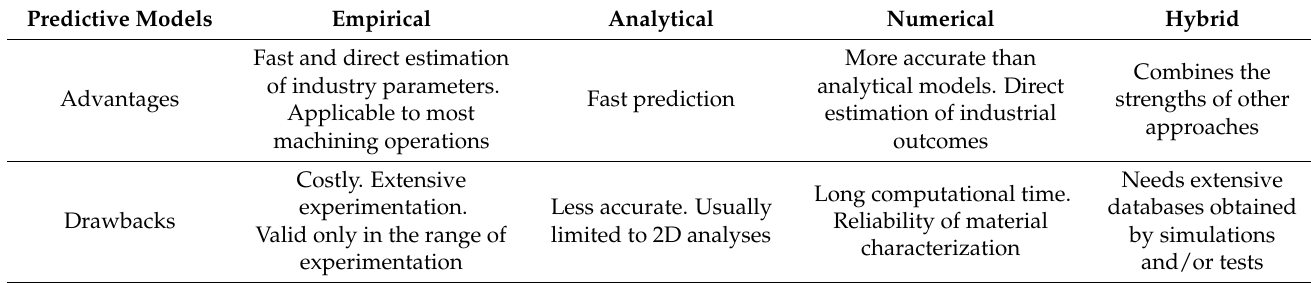
Table 1. Comparative of predictive models employed in machining [3].